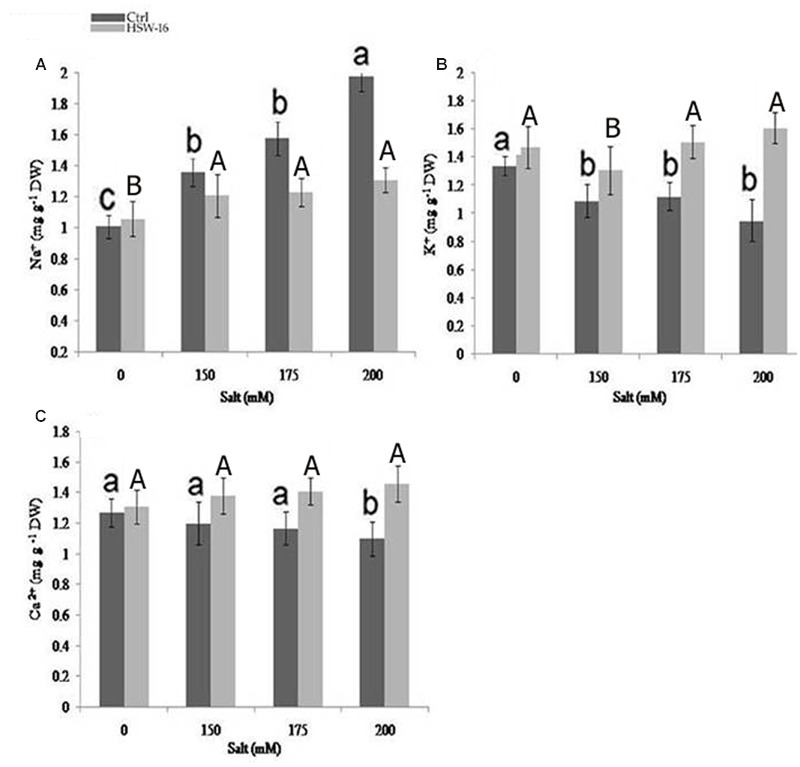
Effect of NaCl and inoculation with B. licheniformis HSW-16 on ionic uptake by plants (A) Na+
(B) K+
(C) Ca+2. Each value is mean of five replicates. Error bar represents standard error of five replicates of mean. Small letters on the bar in each treatment indicate significant difference (p < 0.05) among control, whereas capital letters indicate significant difference among the bacterial treatment. Dark and light gray columns represent the control (Ctrl) and HSW-16 inoculated plants, respectively.